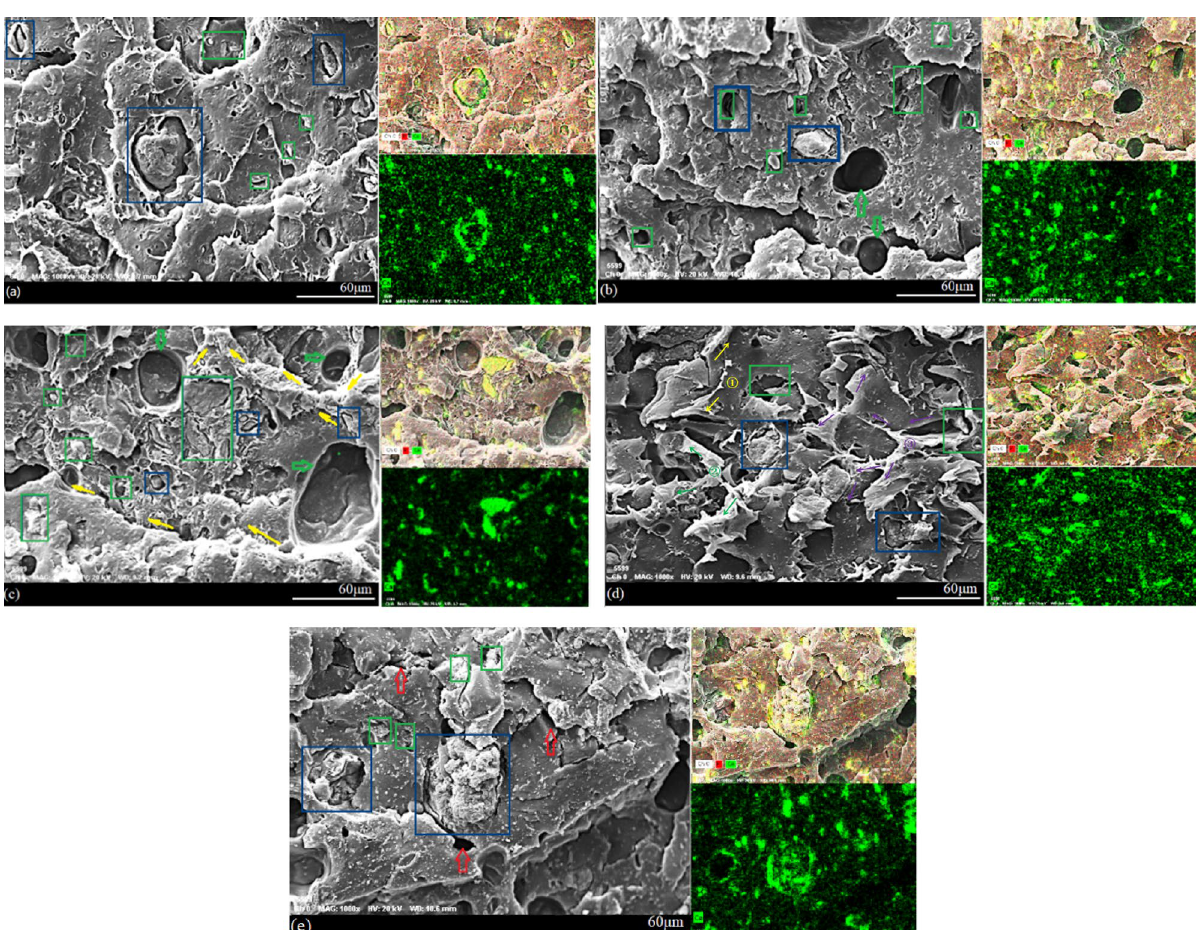
Figure 6. Micrographs of the tensile fractured surface of the PLA/WS/HA composites: ( a ) W3H3, ( b ) W3H8, ( c ) W3H15, ( d ) W8H3 and ( e )